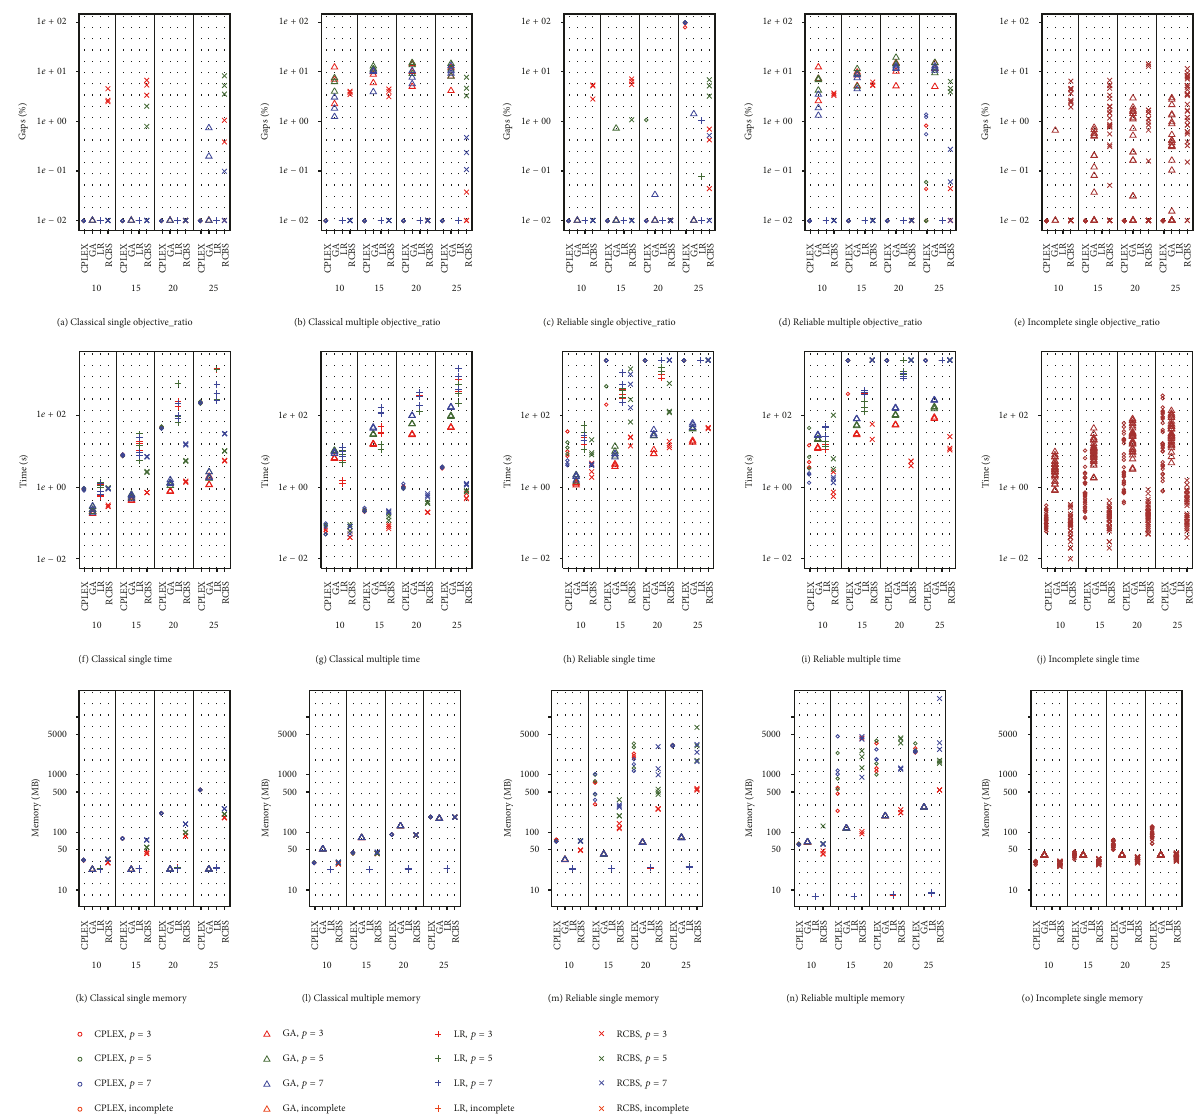
Figure 8: Results of five types of problems for CAB dataset. The problems in five columns are CSA, CMA, RSA, RMA, and ISA. The measurements of three rows are solution gaps, computation time, and main memory usage, respectively. In each subfigure, the results for different numbers of nodes (𝑛 ∈ {10, 15, 20, 25}) obtained with four methods are